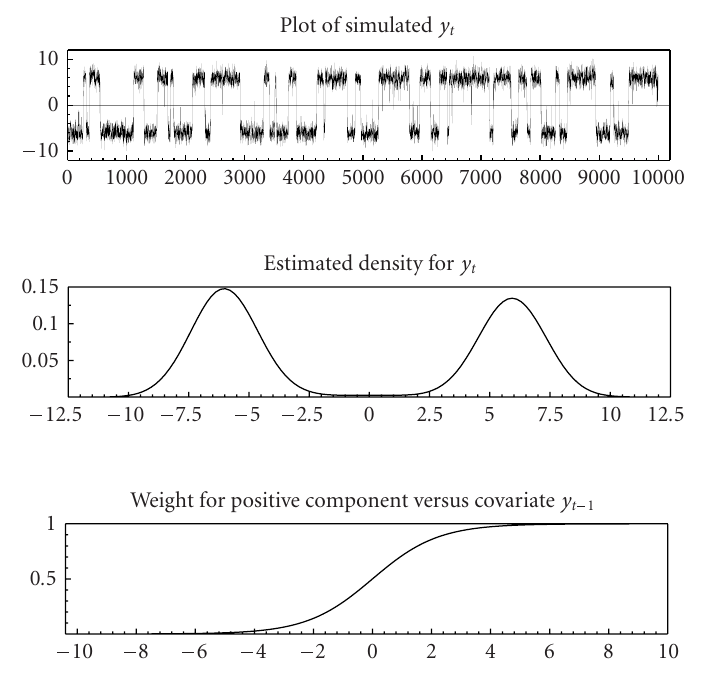
Figure 3.1. Generated time series (a), density estimate for the observed series (b), and weight g 1 ( y t − 1 ) for the positive mean autoregression (c) in the first example. The autoregressive coe ffi cient for each expert is assumed to be 0 .